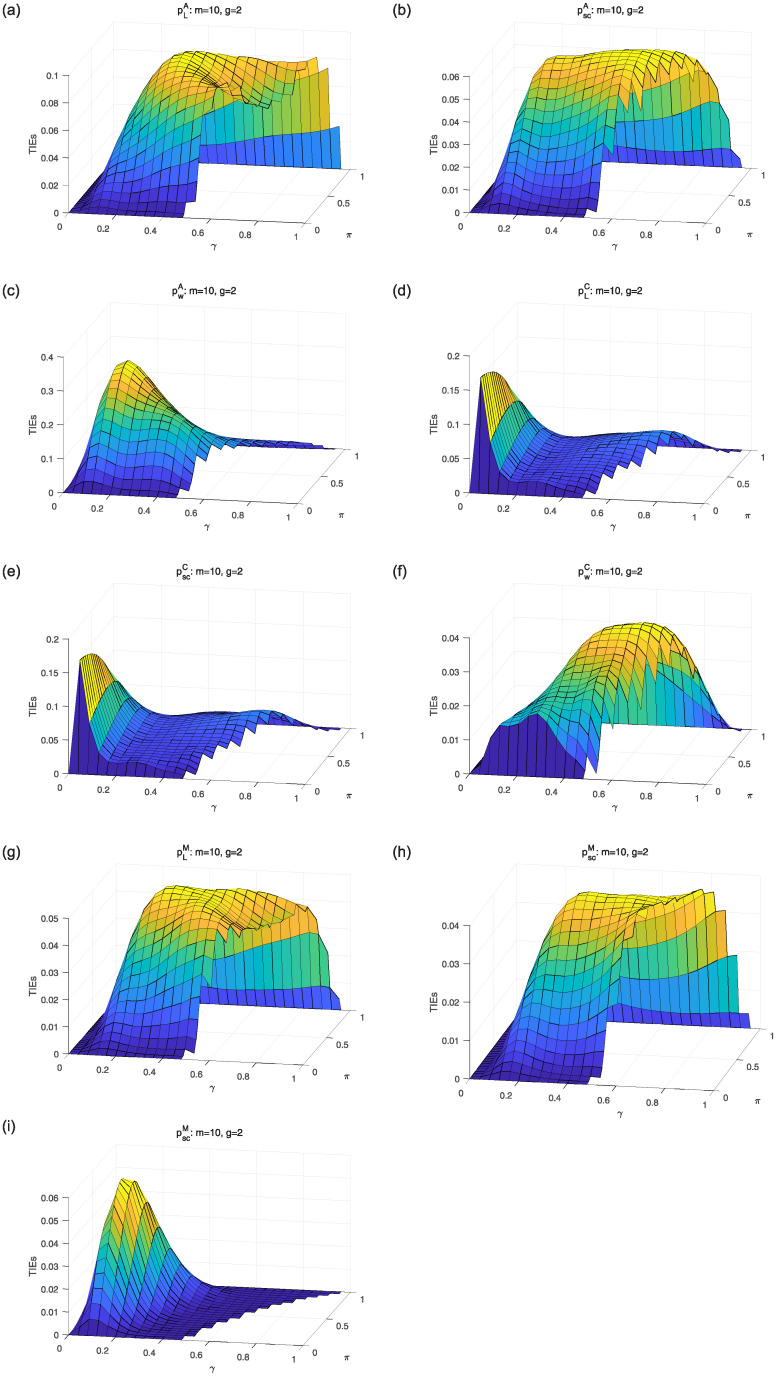
TIE surfaces of exact approaches for m = 10, g = 2, πi = π and γi = γ.